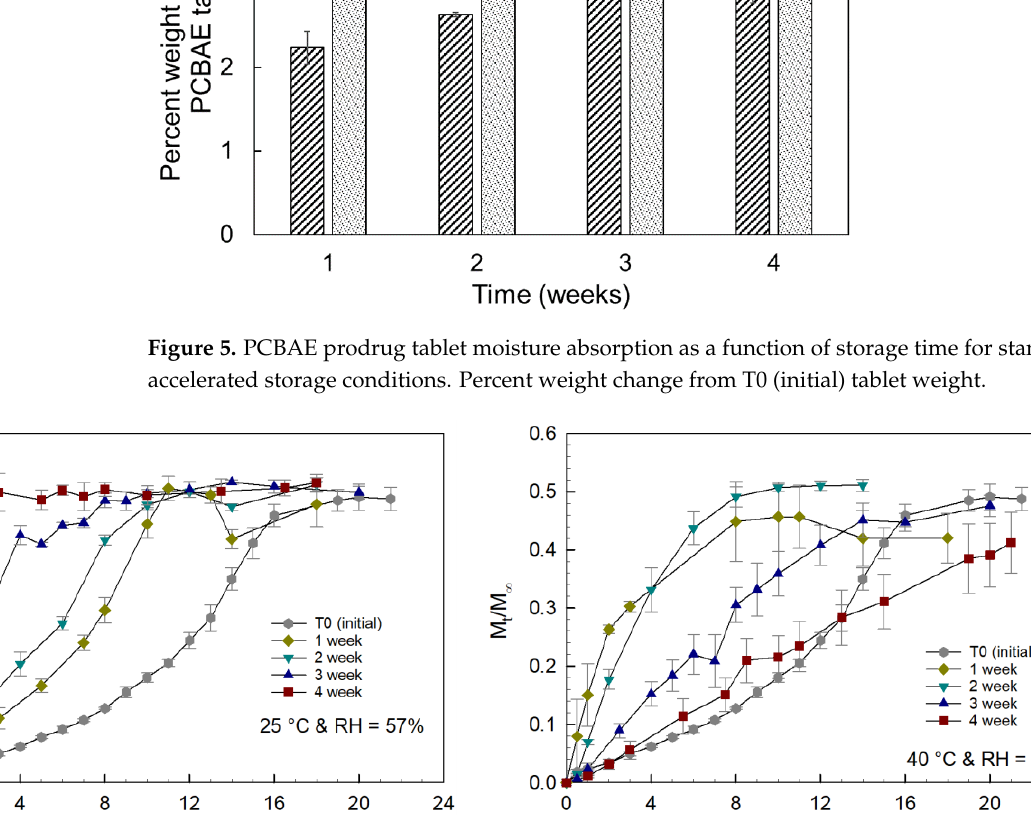
Figure 7. Free curcumin concentration based on HPLC analysis (elution between 5 and 6 min) of the final degradation supernatants collected from the dissolution of PCBAE prodrug tablets stored at standard and accelerated conditions. To further understand the delay in the release observed for the tablets stored at the accelerated conditions (40 °C and RH = 75%), another set of PCBAE prodrug tablets was